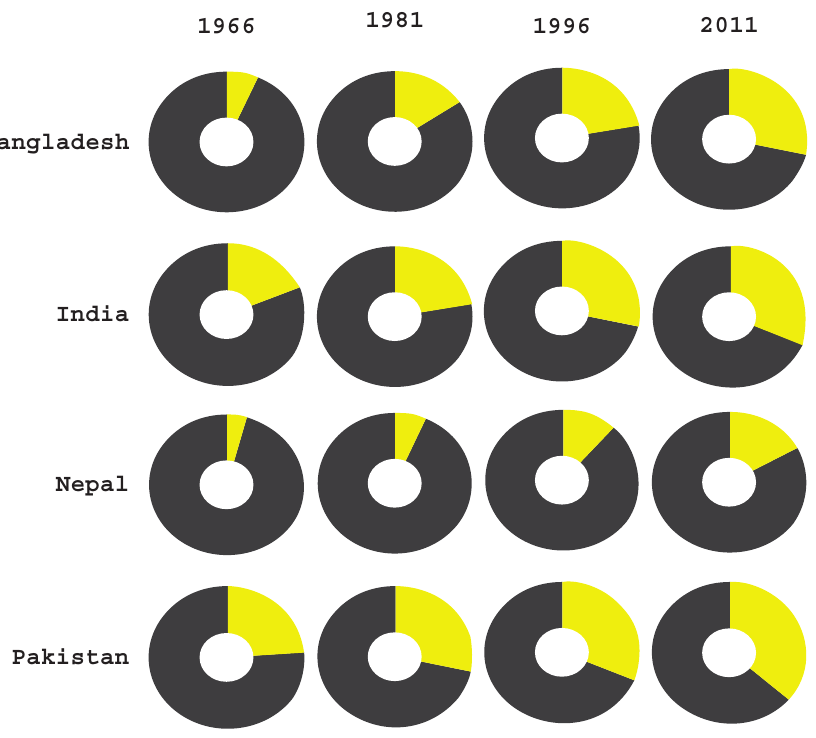
Figure 2. Illustrates the trend of urbanization in South Asia. Pakistan has highest urban population in the region while Nepal has the highest rate of urbanization. Source: UN Population Database, State of world cities